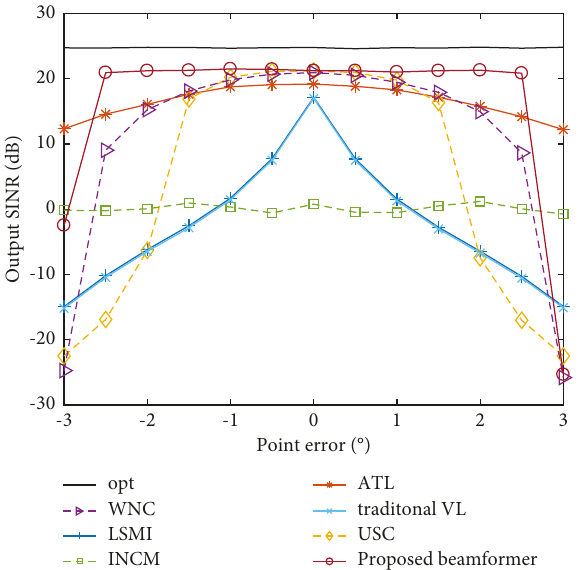
Figure 4: Output SINR versus steering direction error in sufficient snapshot with random sensor position errors.